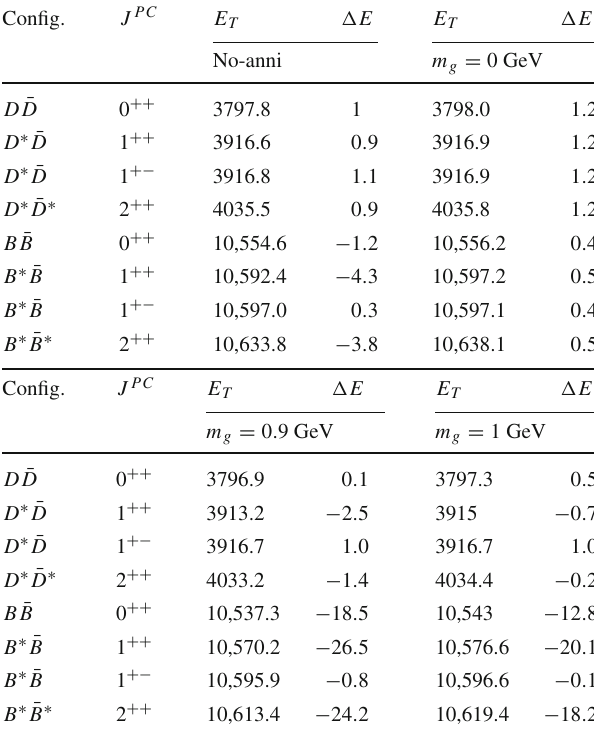
Table 4 Energies (in MeV) of S -wave D ( ∗ ) ¯ D ( ∗ ) and B ( ∗ ) ¯ B ( ∗ ) with different effective gluon mass for the BCN model. ‘No-anni’ means without annihilation interaction Config.